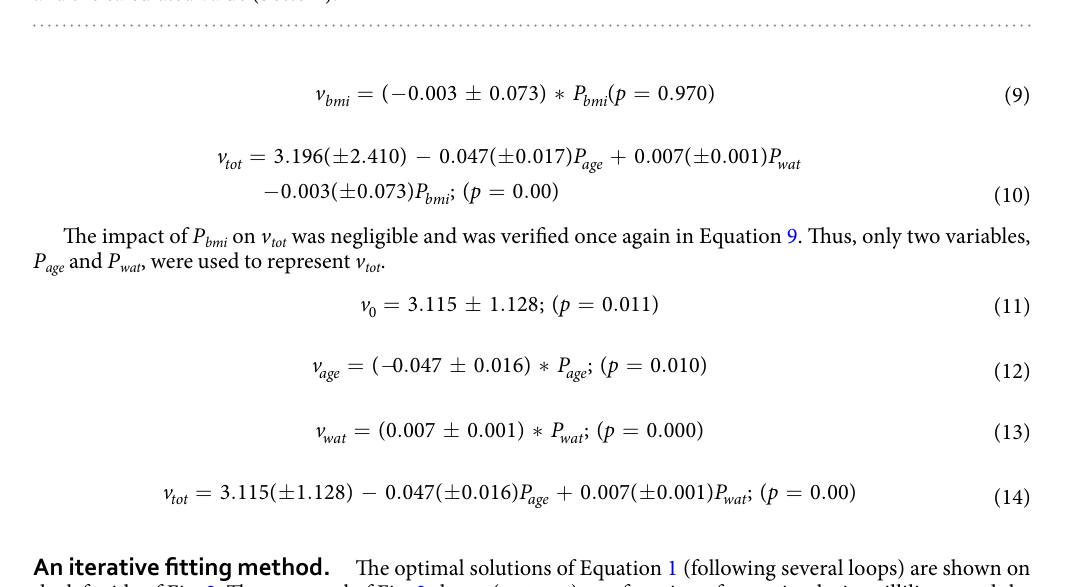
Figure 2. The left panel: v bm i as a function of BMI in kg/m 2 together with linear fitting (bottom); v age as a function of age in years together with linear fitting (middle); ( v 0 + v wat ) as a function of water intake in millilitres together with linear fitting (top). The right panel: The mean urinary inflow rates of all patients, including the measured value and the calculated value using two methods (top); the difference between the measured value and the calculated value